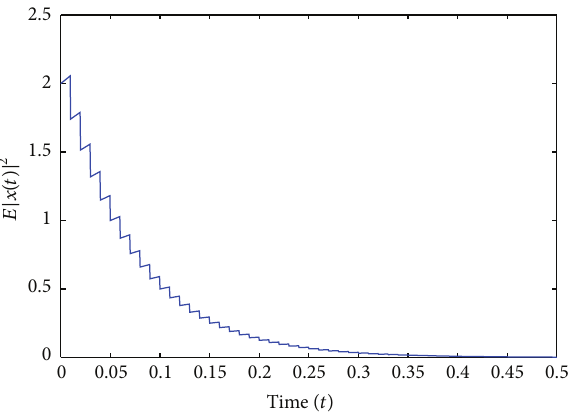
Figure 4: The mean square of the solution to system (51) with impulses (2000